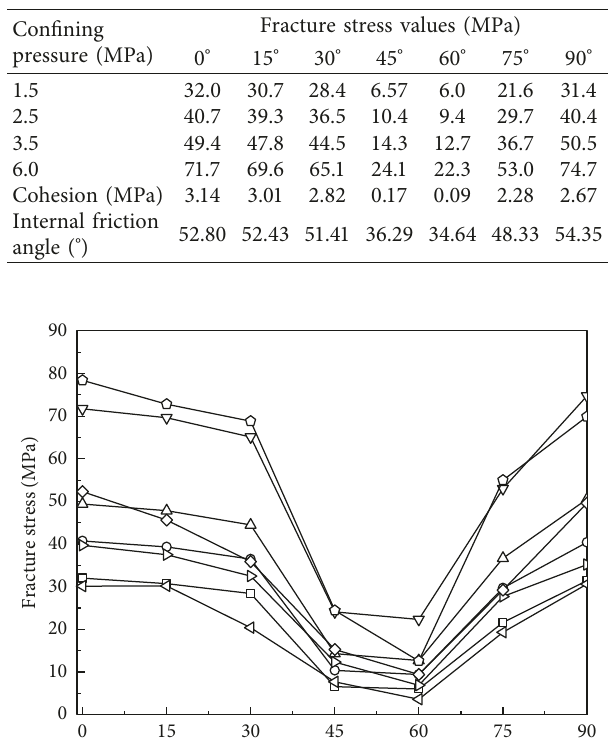
Table 1: Fracture stress values of rockmass with structure planes of different dip